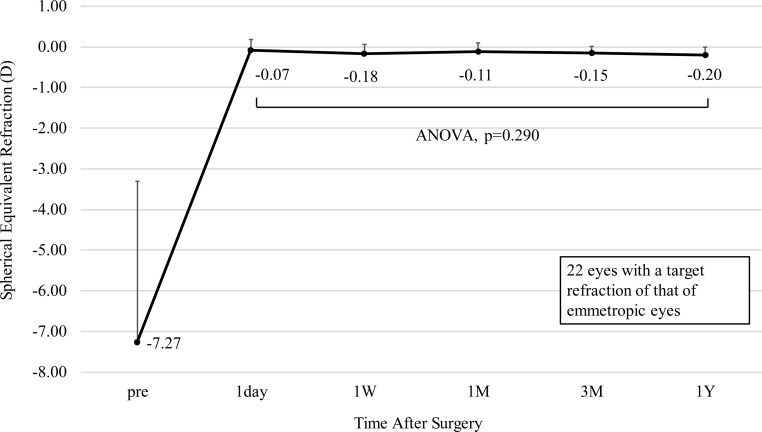
Spherical equivalent refraction after implantation of an implantable collamer lens with a central hole.The points depict mean values and the error bars depict the upper bound of the standard deviation. ANOVA = analysis of variance, D = diopter, W = week, M = month(s), Y = year.